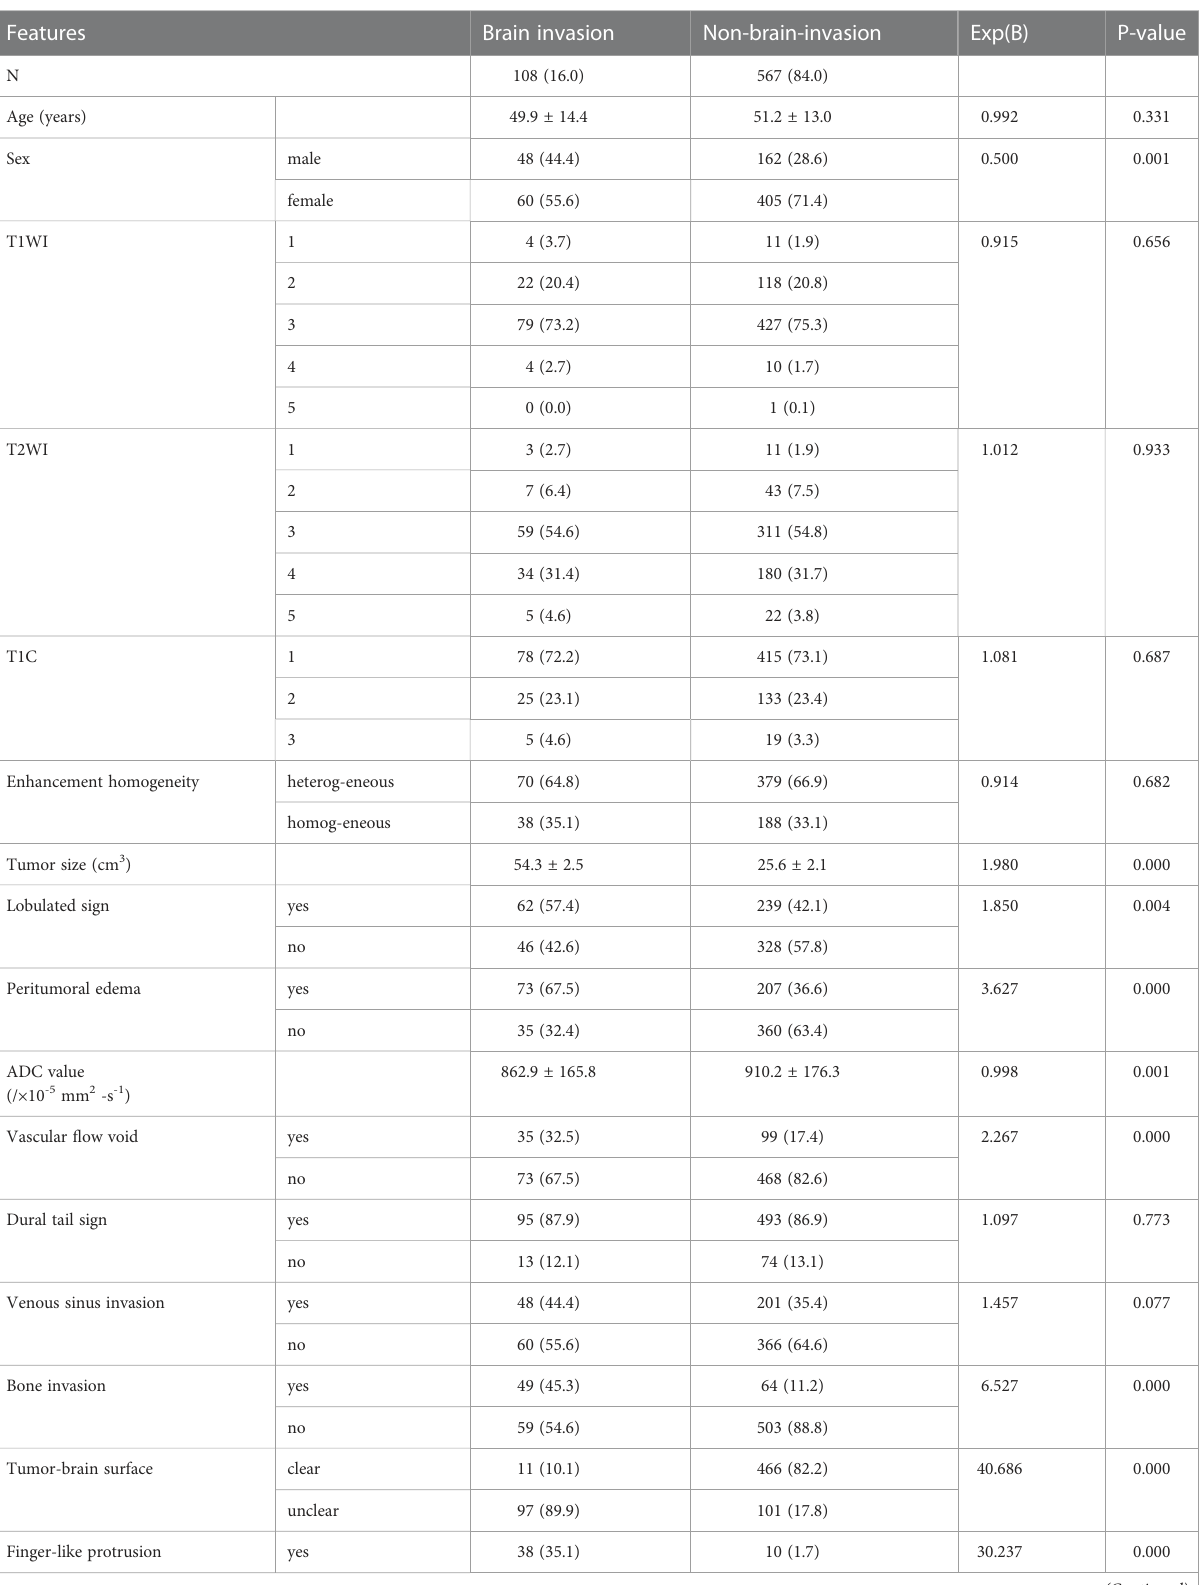
TABLE 3 Univariate analysis of features associated with brain invasion